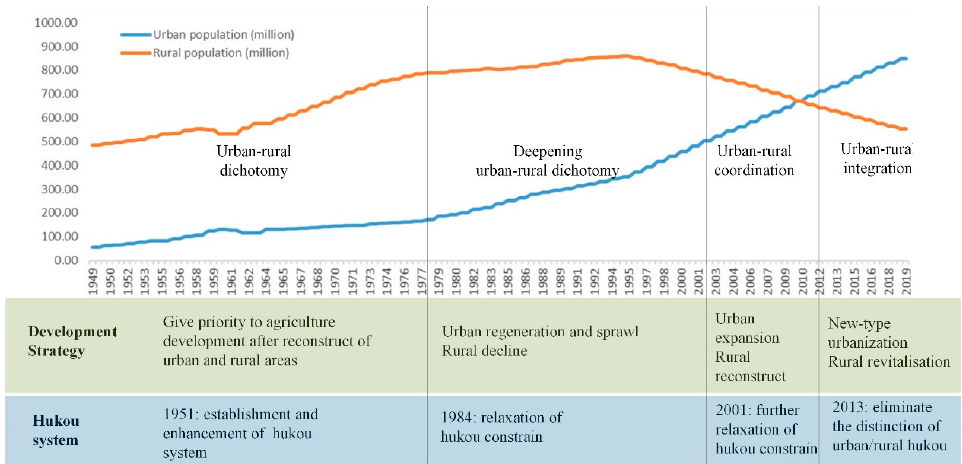
Figure 5. Urban–rural development in China (1949–2019). Data source: National Bureau of Statistics of China.